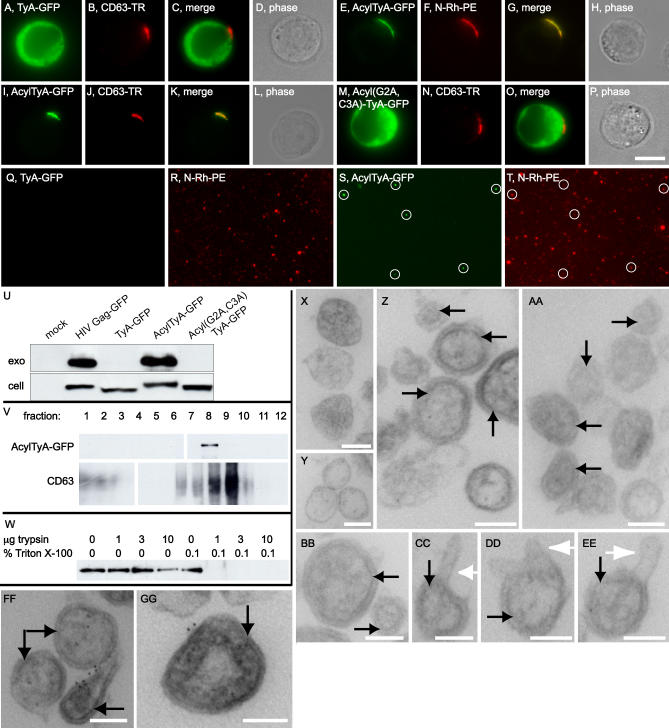
A Plasma Membrane Anchor Targets TyA to ELDs and Exosomes(A–P) Fluorescence microscopy of (A–D) Jurkat T cells expressing TyA-GFP, fixed and stained with antibodies to detect surface CD63; (E–H) N-Rh-PE–labeled Jurkat T cells expressing AcylTyA-GFP; (I–L) Jurkat T cells expressing AcylTyA-GFP, fixed and stained with antibodies to detect surface CD63; (M–P) Jurkat T cells expressing Acyl(G2A,C3A)TyA-GFP, fixed and stained with antibodies to detect surface CD63. Bar indicates 10 μm.(Q–T) Fluorescence microscopy of exosomes secreted by N-Rh-PE–labeled Jurkat T cells expressing (Q and R) TyA-GFP or (S and T) AcylTyA-GFP. White circles mark exosomes that contain both N-Rh-PE and AcylTyA-GFP.(U) Anti-GFP immunoblot of exosomes (exo) and cell lysates (cell) prepared from Jurkat T cells (mock) and Jurkat T cells expressing HIV Gag-GFP, TyA-GFP, AcylTyA-GFP, or Acyl(G2A,C3A)TyA-GFP.(V) Exosomes secreted by Jurkat T cells expressing AcylTyA-GFP were purified by sucrose density centrifugation, fractions were collected from the bottom of the gradient, and equal amounts of each fraction were examined by immunoblot using antibodies specific for (upper panel) GFP and (lower panel) the exosomal marker CD63. Fractions 1–12 were of the densities 1.34, 1.33, 1.33, 1.32, 1.24, 1.20, 1.16, 1.13, 1.11, 1.10, and 1.09 g/ml, respectively.(W) Anti-GFP immunoblot of exosomes collected from Jurkat T cells expressing AcylTyA-GFP and incubated with different amounts of trypsin in the absence or presence of 0.1% Triton X-100.(X–GG) Immunoelectron microscopy of N-Rh-PE–labeled Jurkat T cells expressing (X and Y) Acyl(G2A,C3A)TyA or (Z–GG) AcylTyA. Black arrows denote electron-dense lamina under the membrane of exosomes secreted by cells expressing AcylTyA, white arrows denote exosome protrusions. (FF and GG) Six-nanometer immunogold is directed against rhodamine of N-Rh-PE. Bar indicates 100 nm.